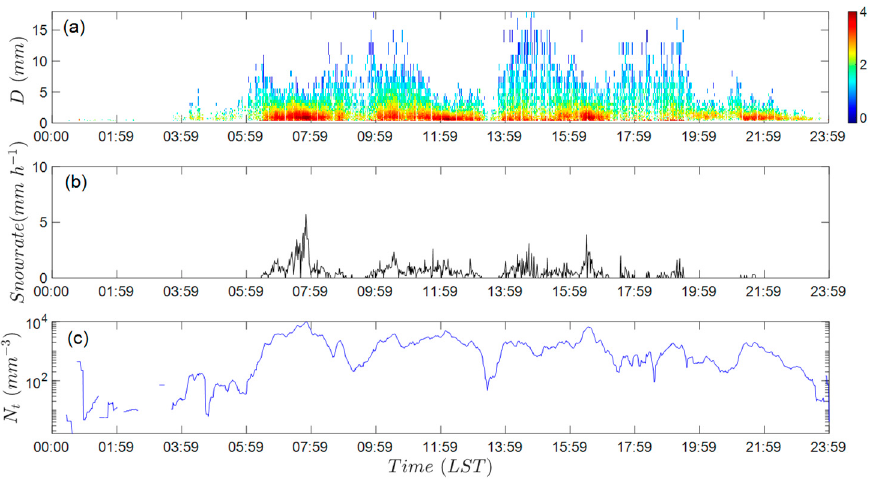
Figure 3. Distribution of ( a ) PSD N ( D ) , ( b ) Snow rate SR and ( c ) Total number concentration N t over time during the snowfall on 13 February 2022.